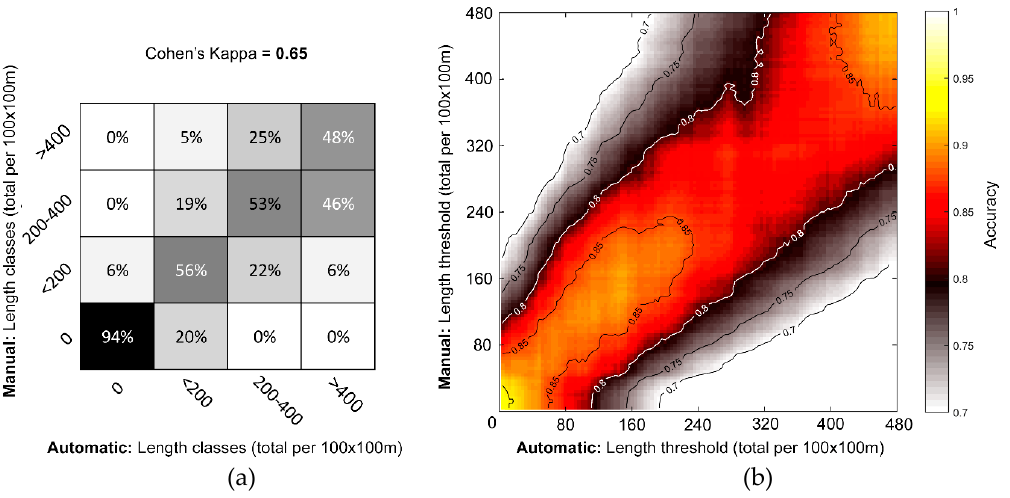
Figure 13. ( a ) The cross-tabulation matrix for the four-classes scenario and ( b ) accuracy versus TM length per unit area threshold.